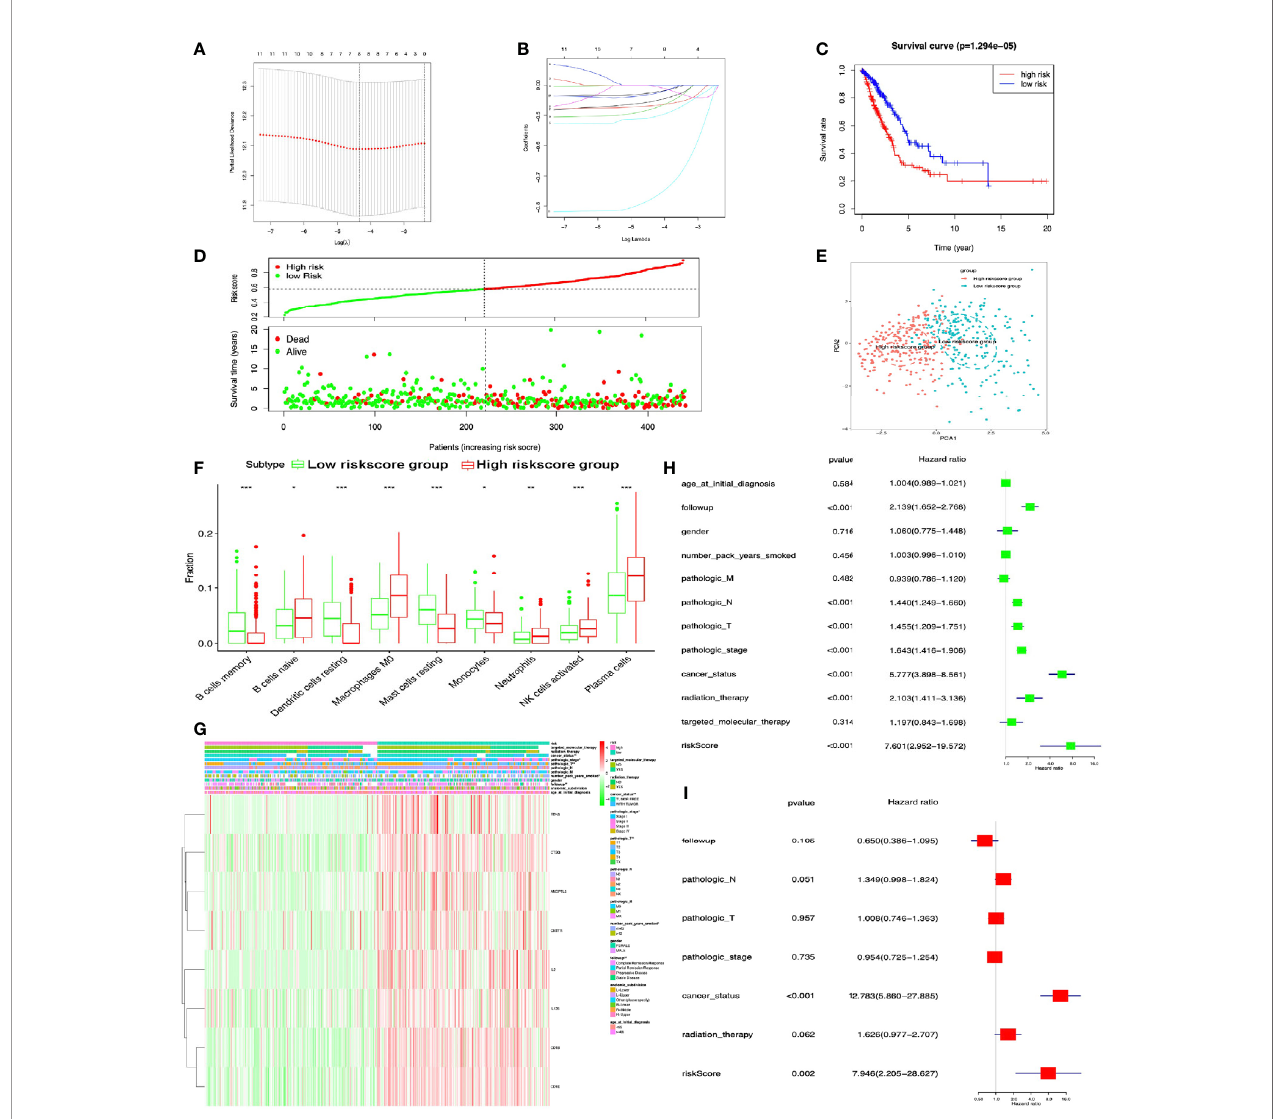
FIGURE 7 | Lasso regression identi fi ed the prognostic model in LUAD. (A, B) Lasso regression complexity was controlled by lambda with glmnet R package. (C) OS analysis between high- and low-risk score groups. (D) Risk plot between high- and low-risk score groups. (E) Principal component analysis (PCA) for risk scores revealed two completely disjoint populations, suggesting that there existed extensive differences in the landscape of risk scores between high- and low-risk score samples. Blue means low-risk score samples; red means high-risk score samples. (F) Boxplot showed the ratio differences of nine immune cells between high- and low-risk score groups in LUAD, and Wilcoxon rank sum was used for the signi fi cance test. (G) The heatmap of clinical correlation between high- and low-risk score groups in LUAD. (H) The univariate Cox regression analysis of risk factors in LUAD. (I) The multivariate Cox regression analysis of risk factors in LUAD. *p < 0.05, **p < 0.01, and ***p